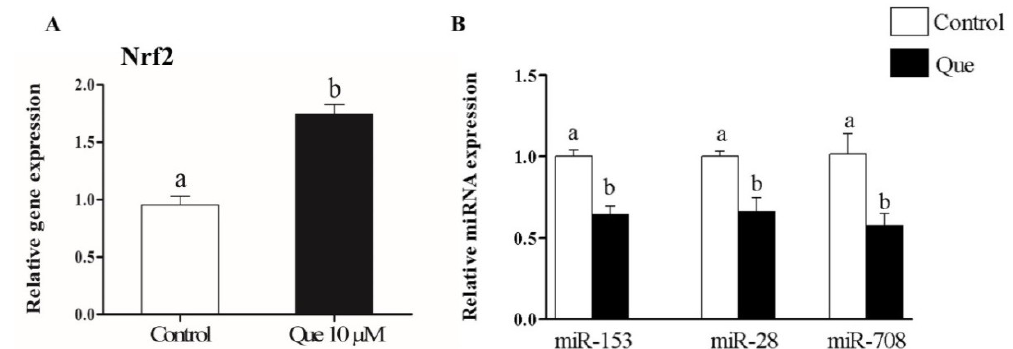
Figure 9. Quercetin increased cellular mRNA expression level of Nrf2 ( A ). The expression of miR-153, miR-28 and miR-708 was downregulated following quercetin treatment of cells ( B ). White bar represent the control groups and dark bars represent quercetin treated group. Data are presented as mean ± SEM of three independent biological replicates. Bars with different letters (a,b) showed statistically significant differences ( p ˂ 0.05).